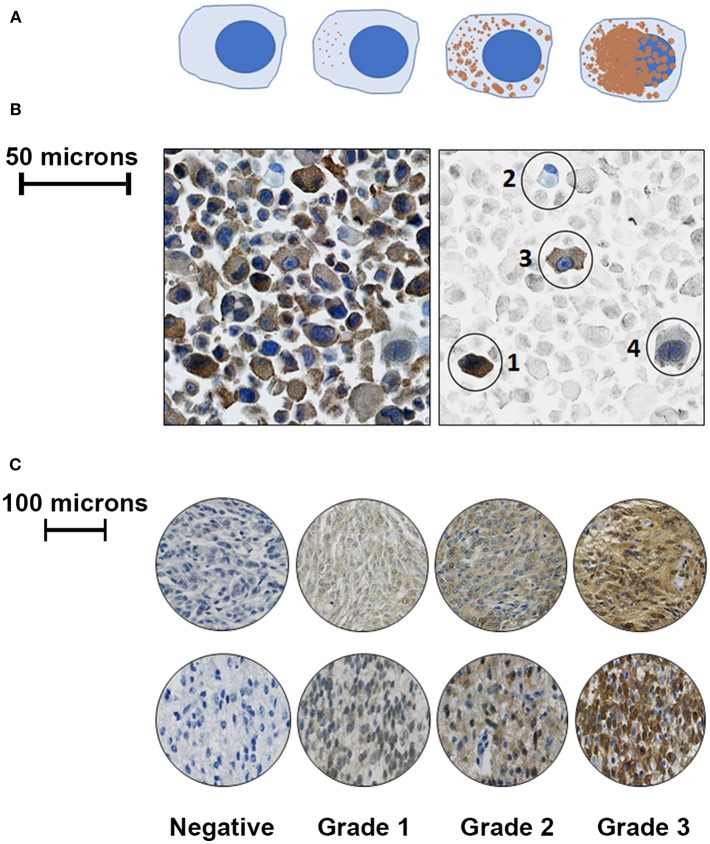
Representative illustrations and images to demonstrate cell grading criteria. (A) Left to right- Negative cells contained no cytoplasmic staining for PC-3; faintly positive cells had < 50% cytoplasmic staining; moderately positive cells had ≤ 50% positive cytoplasmic staining; and strongly positive cells had extensive cytoplasmic staining obscuring cellular nuclear detail. (B) Left: unaltered view of PC-3 immunostaining from a malignant canine astrocytoma. Right: Same image with representative cells in color, while the background cells are faded; from left to right: (1) a strongly staining cell, (2) a negatively staining cell, (3) a moderately staining cell, and (4) a faintly staining cell. (C): Representative images of canine meningioma samples (top row) and astrocytoma tissue microarray cores (bottom row) that were graded following evaluation of 500 cells using the above criteria.